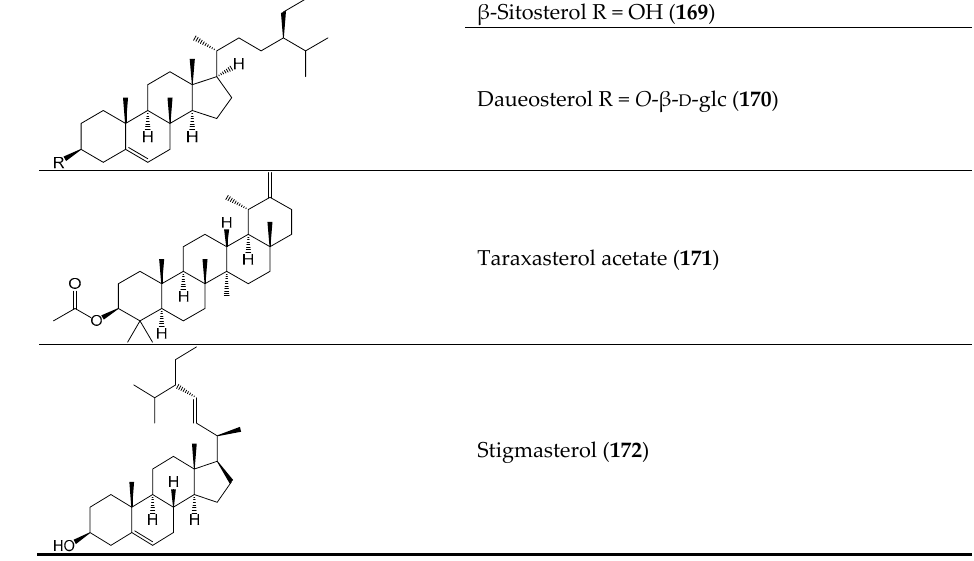
β -Sitosterol R = OH ( 169 )